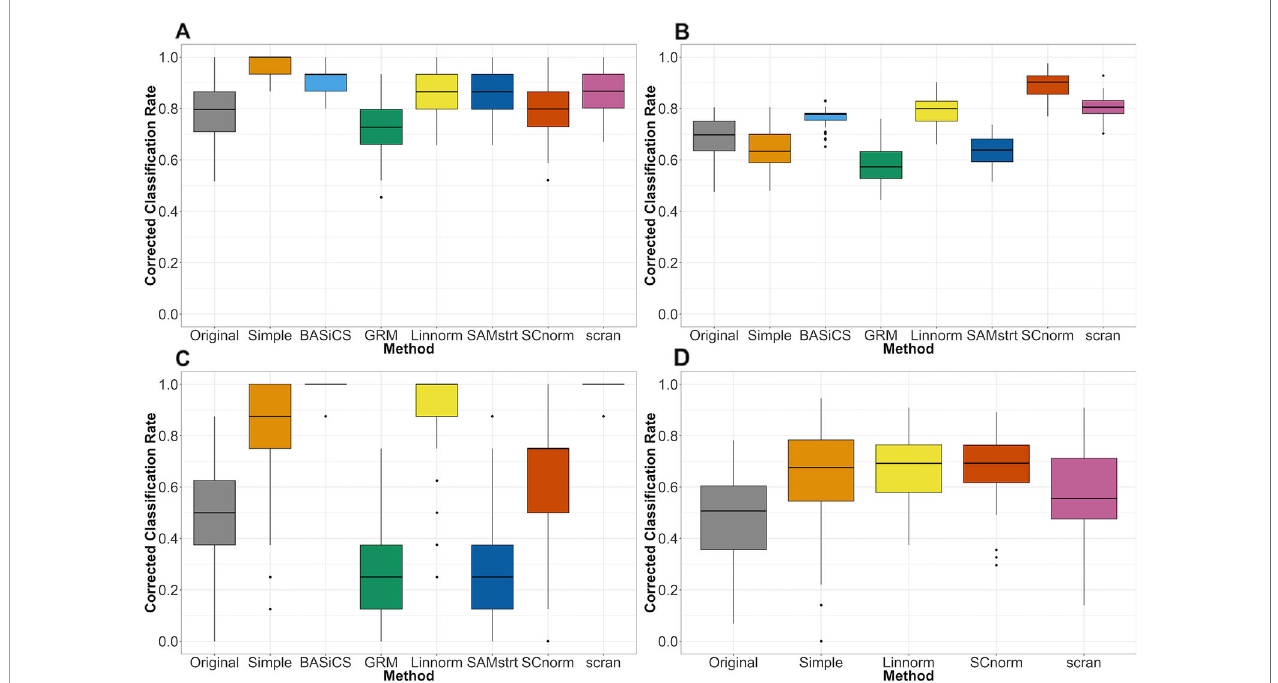
FIGURE 6 | Comparison of normalization methods using the Cohen's kappa statistic. Statistics measuredover 100 random samples. (A) Mouse embryonic data (B) Mouse lung data (C) 2-fold change simulated data (D) Human embryonic